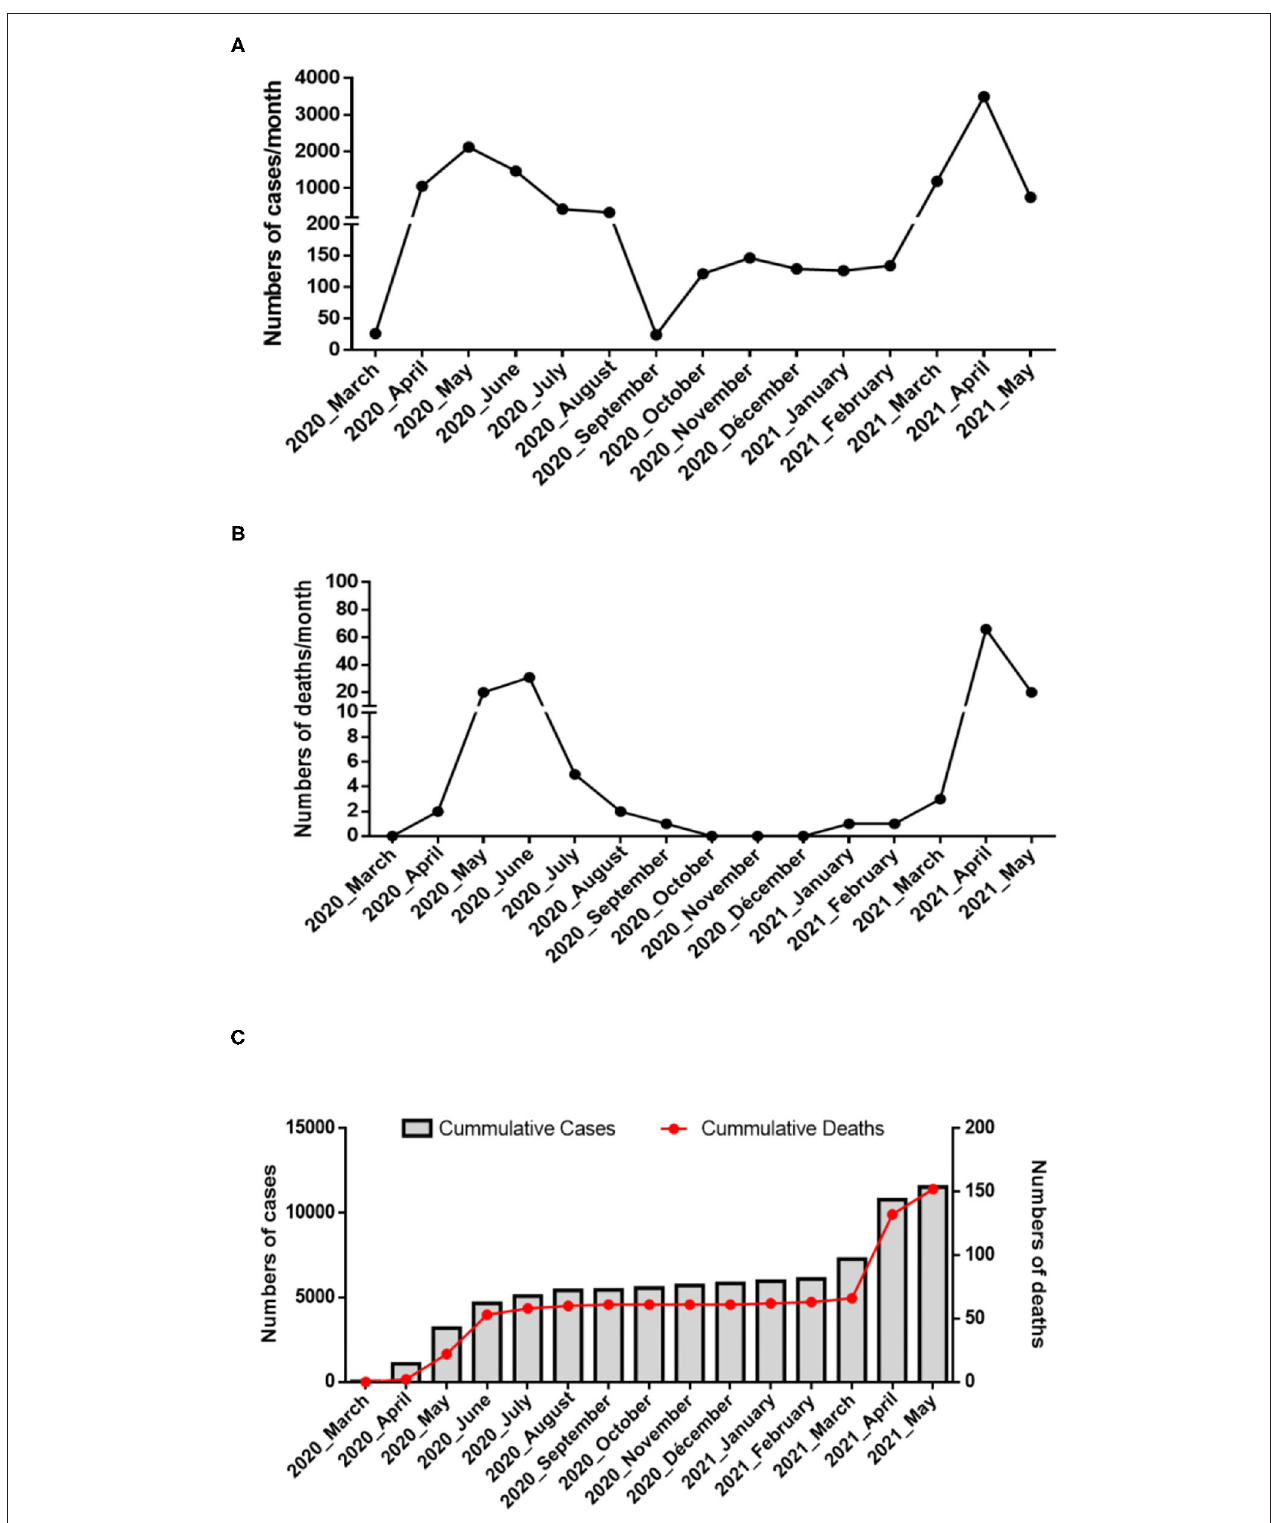
FIGURE 2 | Epidemiology of COVID-19 in Djibouti. Summary of the COVID-19 outbreaks in the Republic of Djibouti. (A) Epidemiological data regarding the COVID-19 episodes compiled from information provided by the WHO from March 2020 to May 2021 (https://www.who.int/emergencies/diseases/novel-coronavirus-2019/ situation-reports/). Three periods (first wave, inter-wave, second wave) were provisionally defined during which samples were collected for the genetic analysis of the SARS-CoV-2 strains. (B) Number of deaths over time. (C) Cumulative number of COVID-19 cases and SARS-CoV-2-associated deaths in Djibouti.